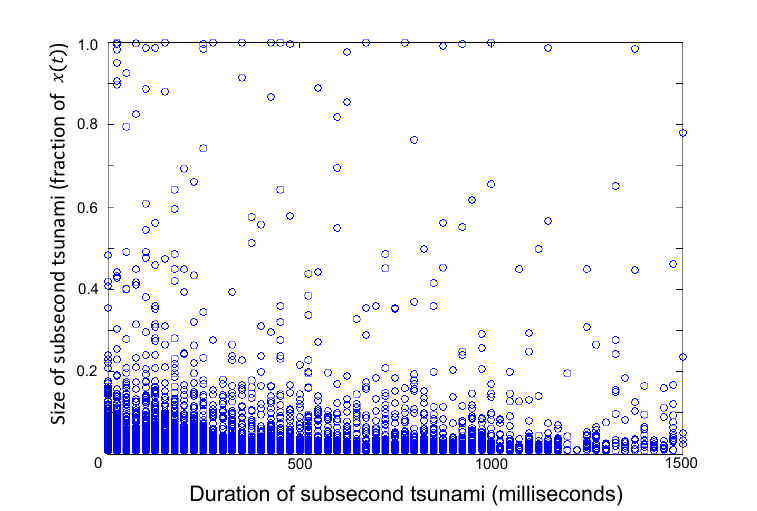
Figure 2. Size and duration for the ultrafast tsunamis that we observed in the 5-year period of data. There is no well-defined relationship between their size and duration. The fact that their size and duration are not trivially linked helps confirm their surprising